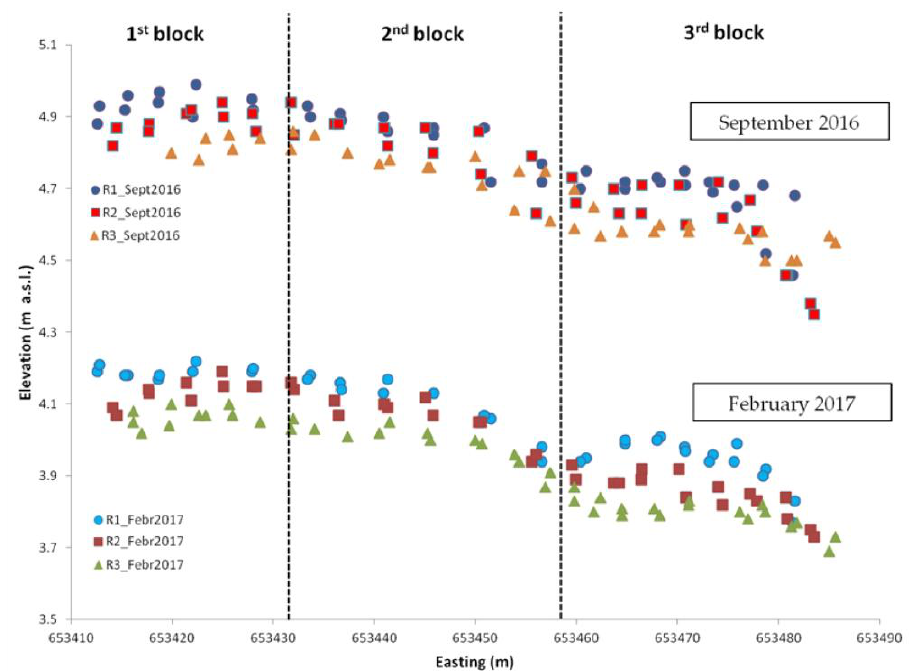
Figure 4. Trend of the three ridges for September 2016 and February 2017, before and after the extreme event, respectively.